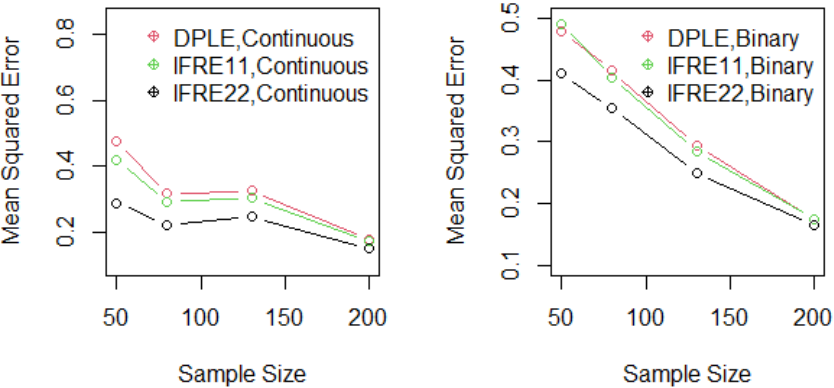
Figure 1. Plots of mean squared errors for sample sizes and continuous and binary covariate types in double-penalized maximum likelihood estimator for logistic regression